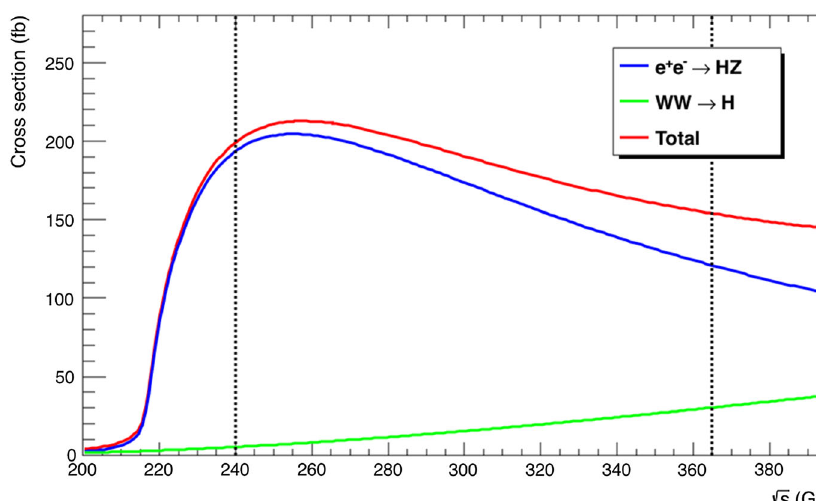
Fig. 4.1 The Higgs boson production cross section as a function of the centre-of-mass energy in unpolarised e + e − collisions. The blue and green curves stand for the Higgsstrahlung and WW fusion processes, respectively, and the red curve displays the total production cross section. The vertical dotted lines indicate the centre-of-mass energies of choice at the FCC-ee for the measurement of the Higgs boson